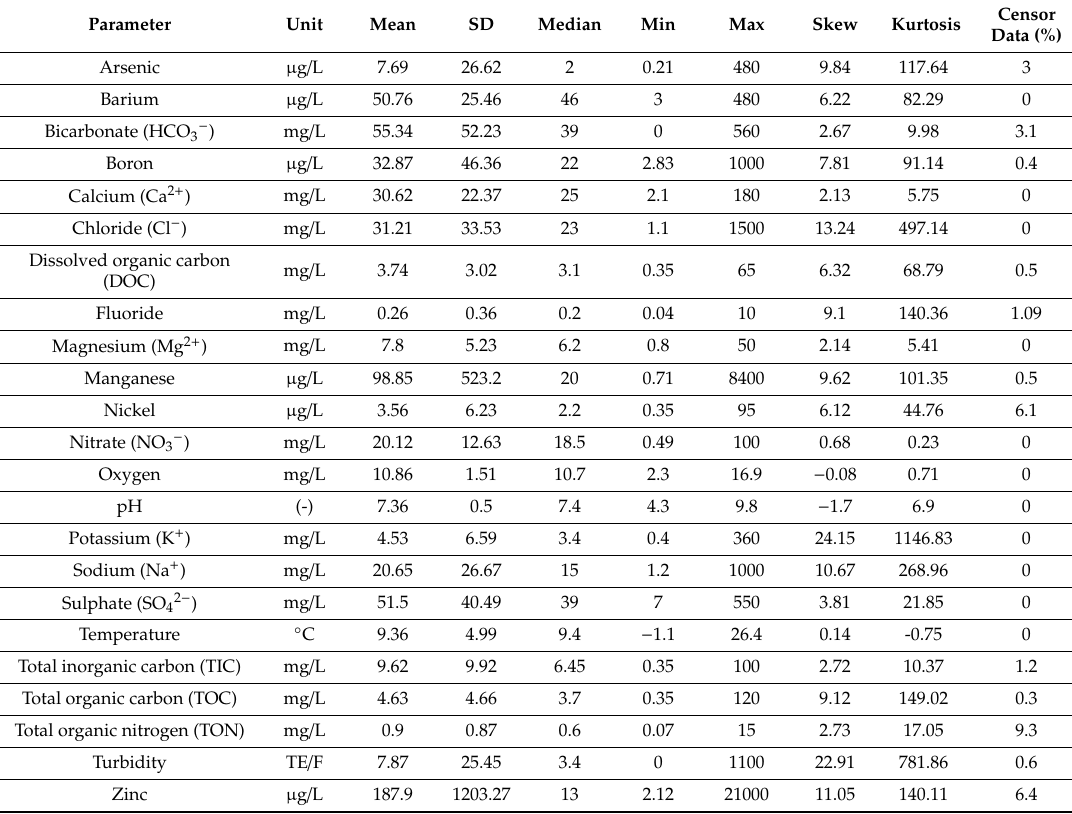
Table 1. Statistical summary of 23 analyzed water quality parameters in the Freiberger Mulde river basin from 2006 to